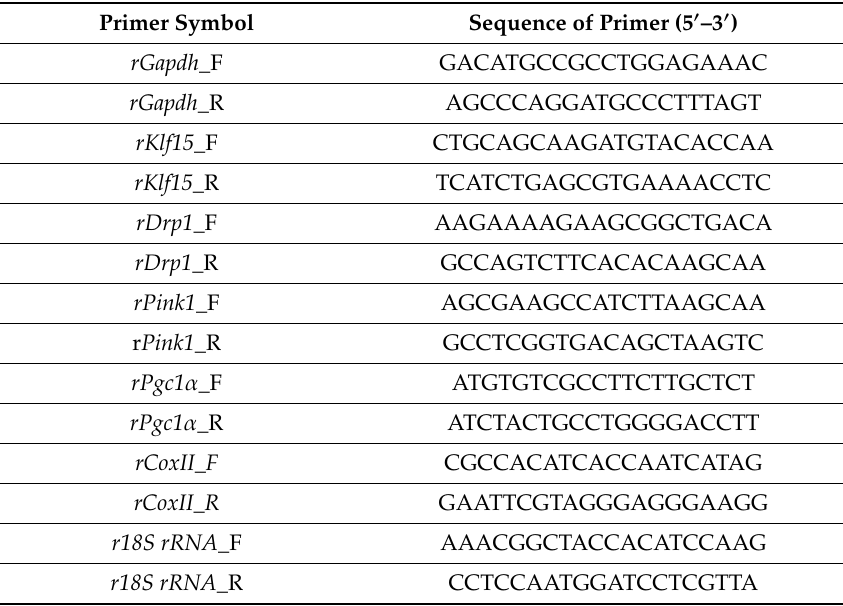
Table 2. Primers used for RT-qPCR